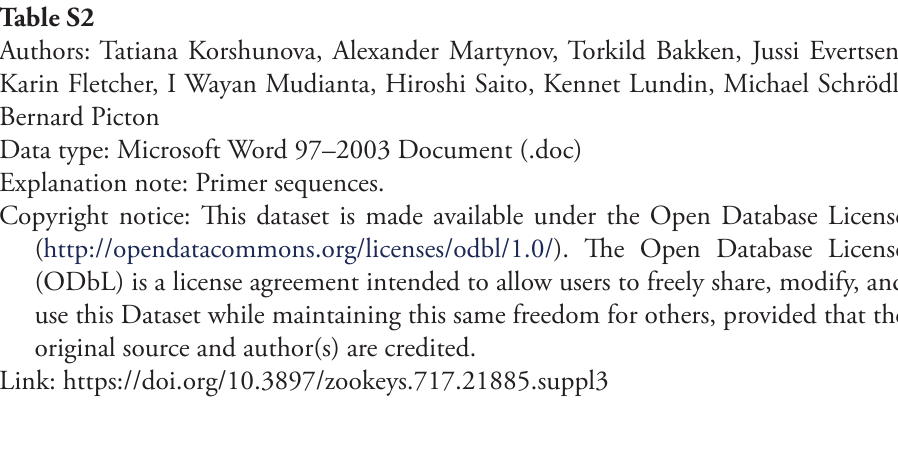
Authors: Tatiana Korshunova, Alexander Martynov, Torkild Bakken, Jussi Evertsen,